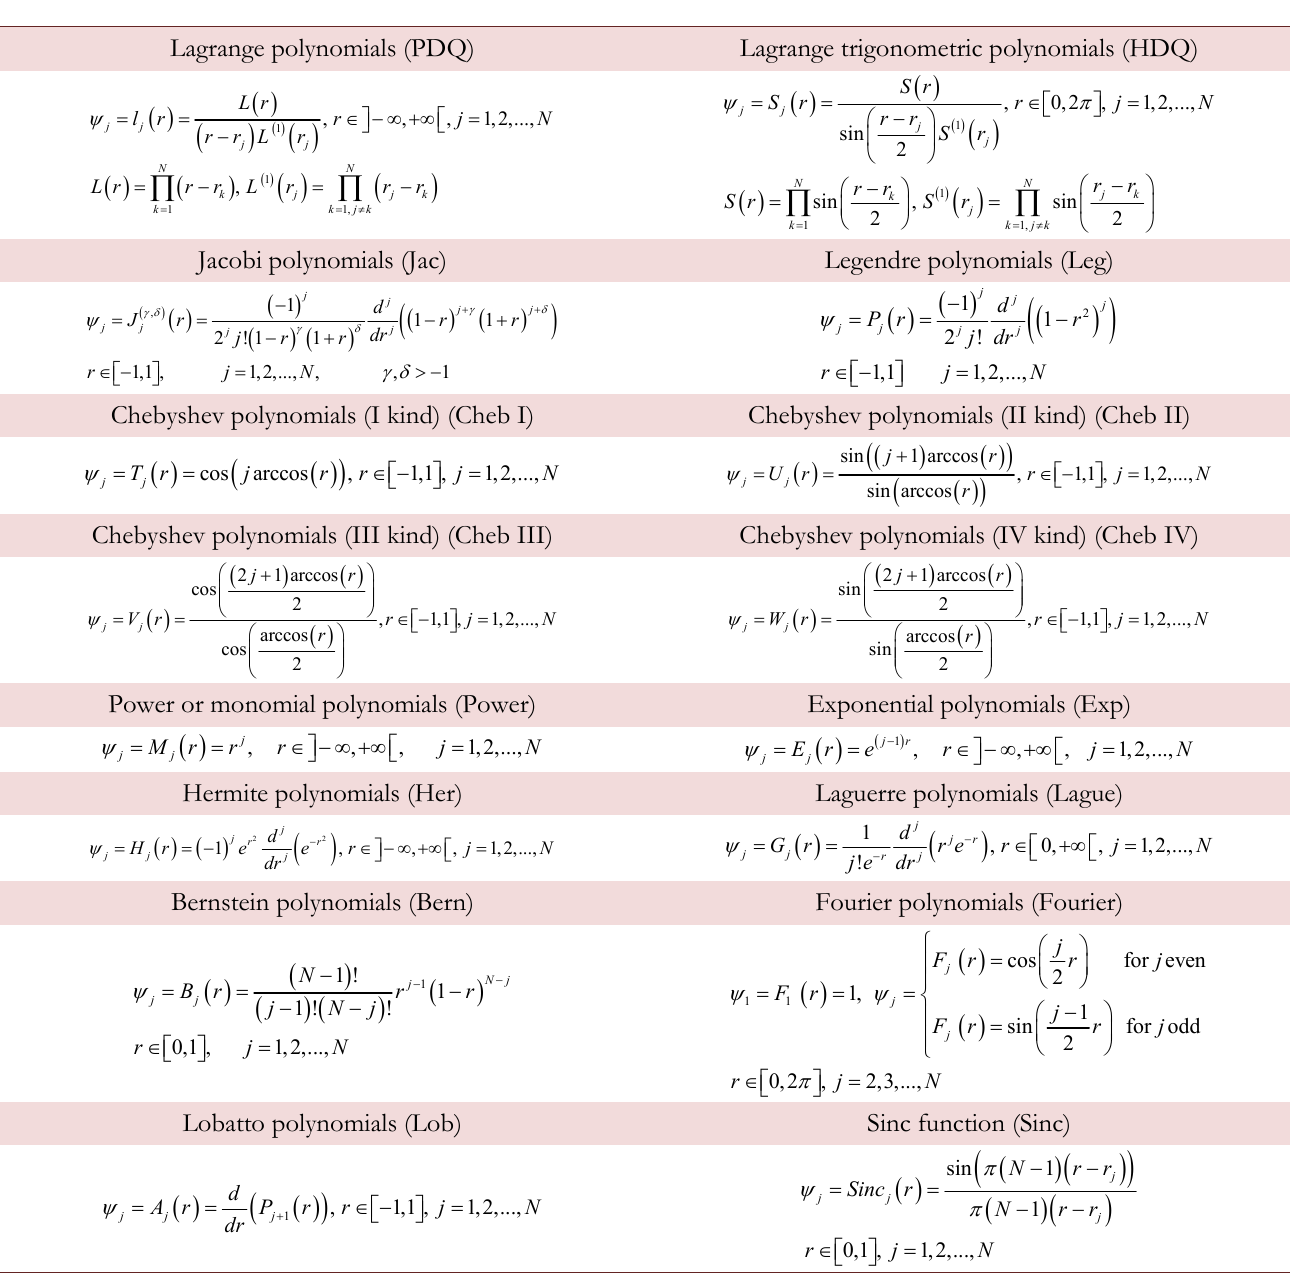
Table 1: List of several basis functions